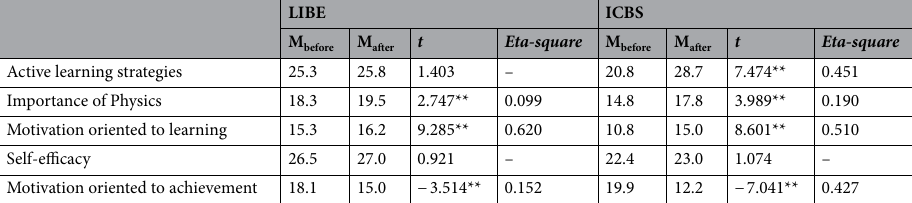
Table 3. Contribution of applied teaching approaches to observed motivational components. ** p <